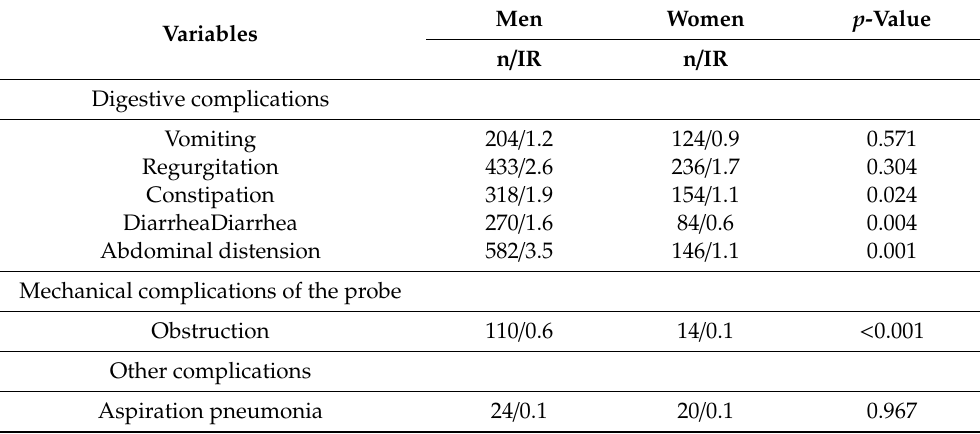
Table 3. Number of episodes ( n ) and incidence rate (IR) of HEN-related